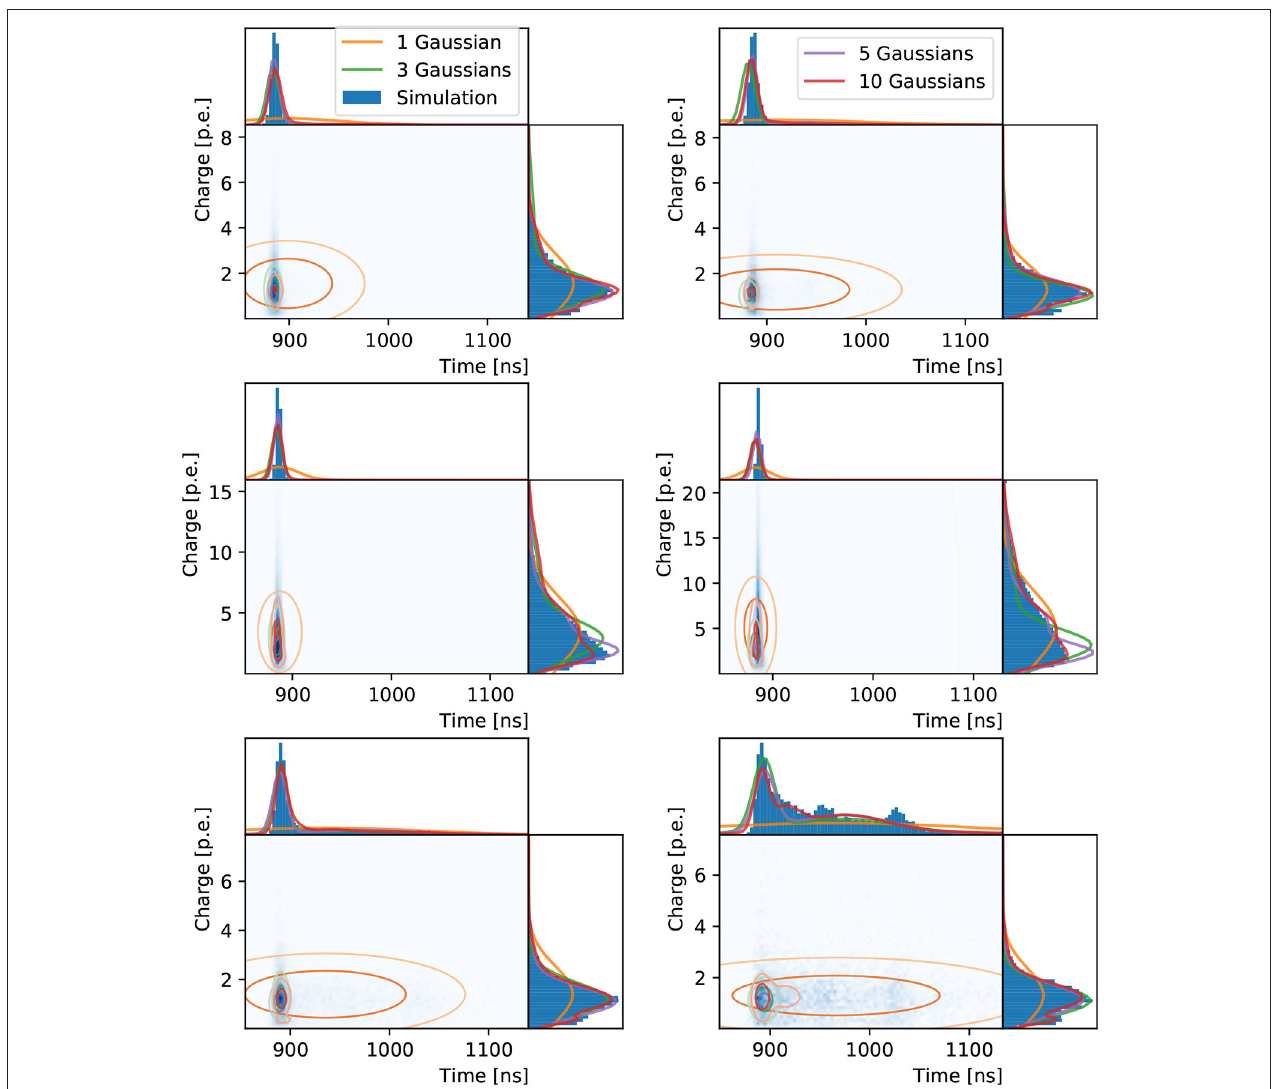
FIGURE 6 | Distributions of hit charges and times for electrons (left) and muons (right) events in the three reference PMTs: in the center (top) , edge (middle) , and outside (bottom) of the Cherenkov ring. The two-dimensional distributions are shown with time on the abscissa and charge on the ordinate together with their one-dimensional projections and the neural network